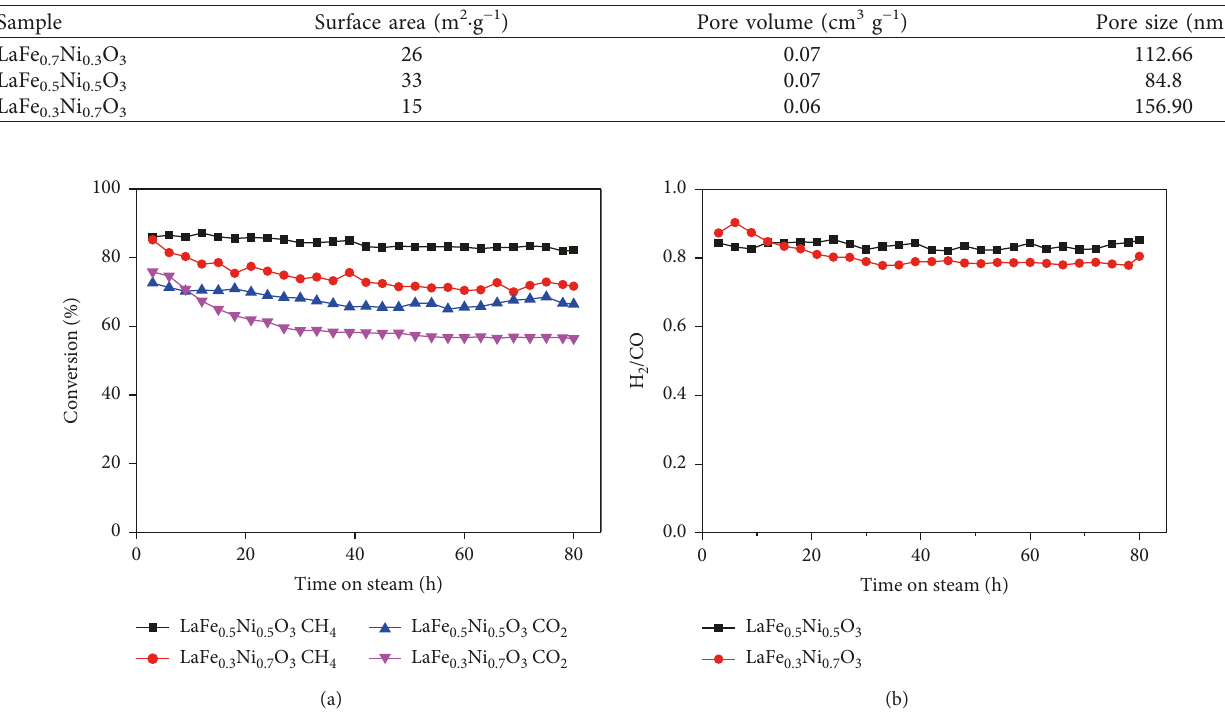
Figure 5: Variations in the conversion of LaFe